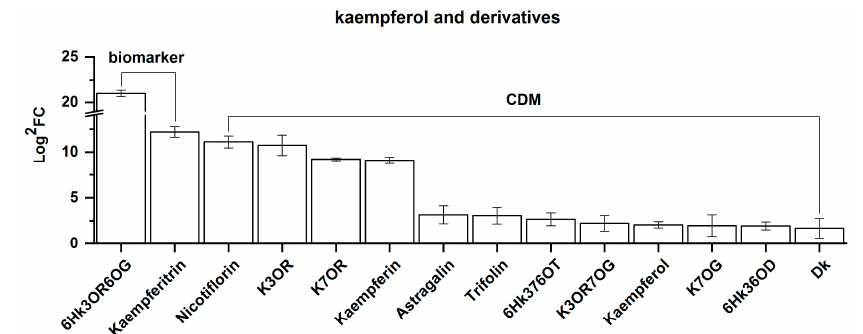
Figure 6. Comparison of fourteen di ff erential metabolites of kaempferol and kaempferol derivatives between SJL and SN. These 14 metabolites were divided into 2 biomarkers and 12 common di ff erential metabolites (CDMs). Upregulation denotes that the content of a metabolite increased in SN when compared with that in SJL. The Y -axis is shown as Log 2 FC values for the convenience of visual presentation (Note: The up-amplitude in the text refers to the FC value). The X -axis denotes